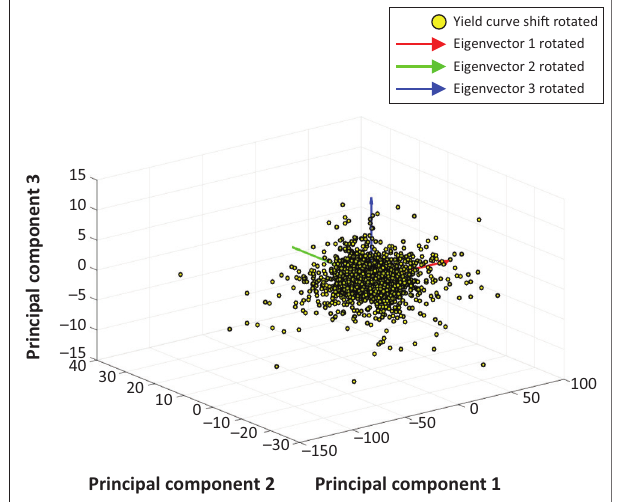
FIGURE 4: Projection of yield curve shifts across 10 maturities onto a three- dimensional space.